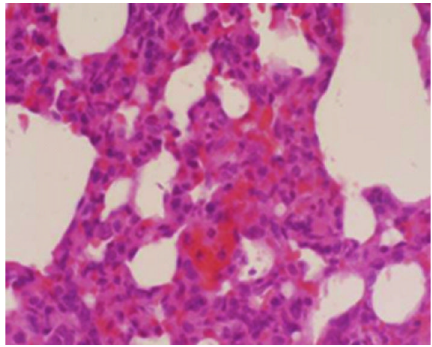
Figure 8: Treated group 28 days; capillary distension and conges- tion in the alveolar wall as well as inflammatory cell infiltration in the alveolar septum; HE × 400.